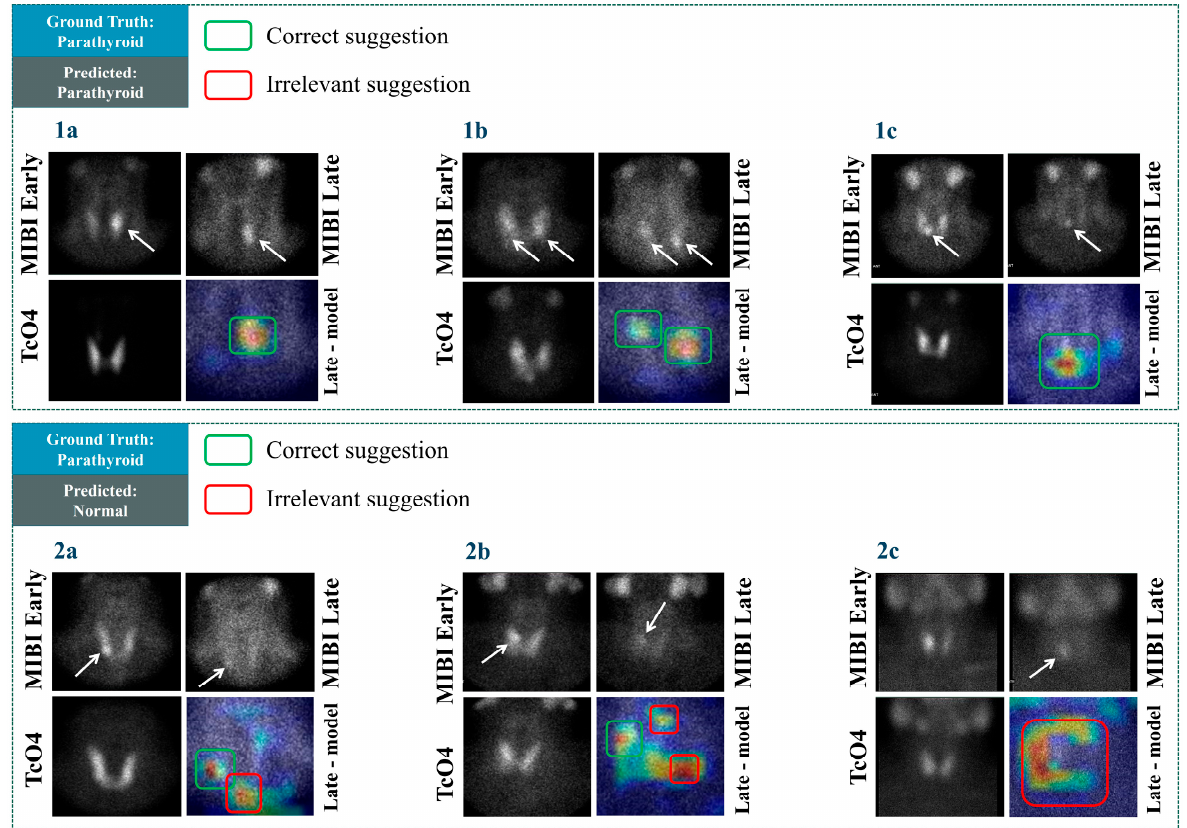
Figure 6. Grad-CAM results in some cases with positive scintigraphic results.